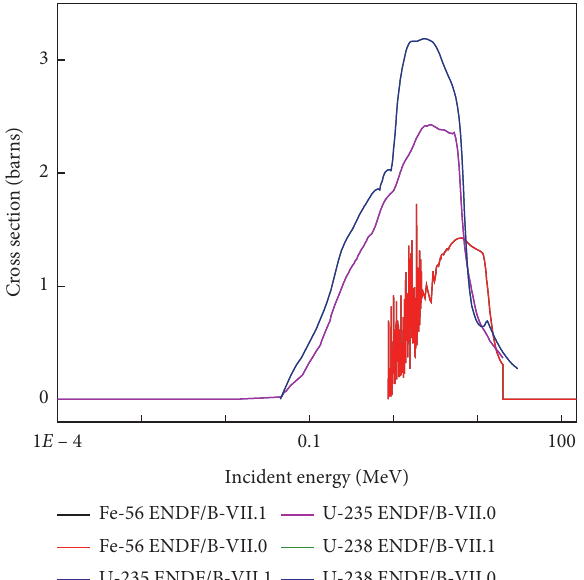
Figure 22: 56 Fe, 235 U, and 238 U inelastic scattering cross sections of ENDF/B-VII.0 and ENDF/B-VII.1.